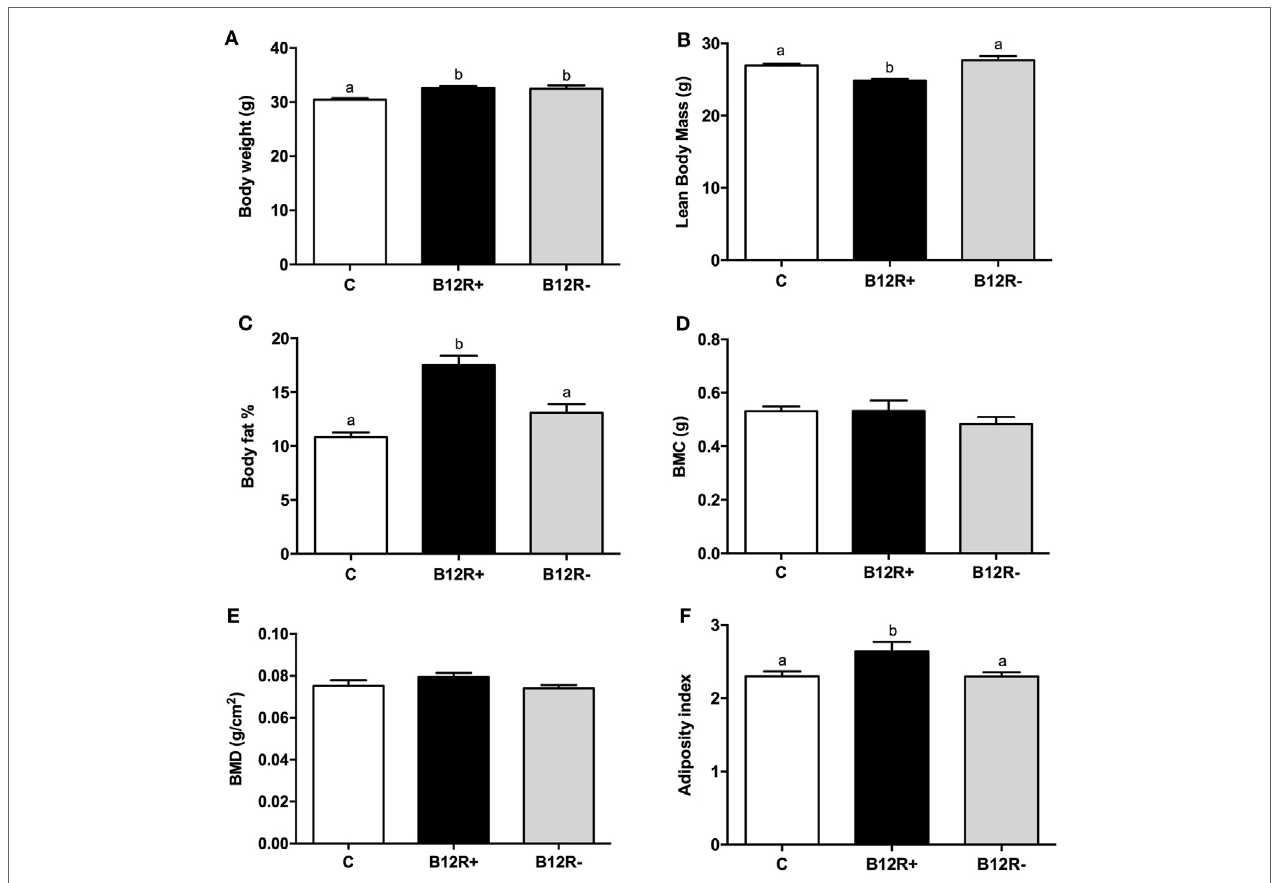
FigUre 2 | Body composition analysis by DeXa after 12 weeks of feeding: (a) body weight, (B) lean body mass, (c) body fat%, (D) body mineral content, (e) body mineral density, and (F) adiposity index. Bars with different superscripts (a/b/c) are significantly different from one another at p < 0.05 by one-way ANOVA/Bonferroni’s post hoc